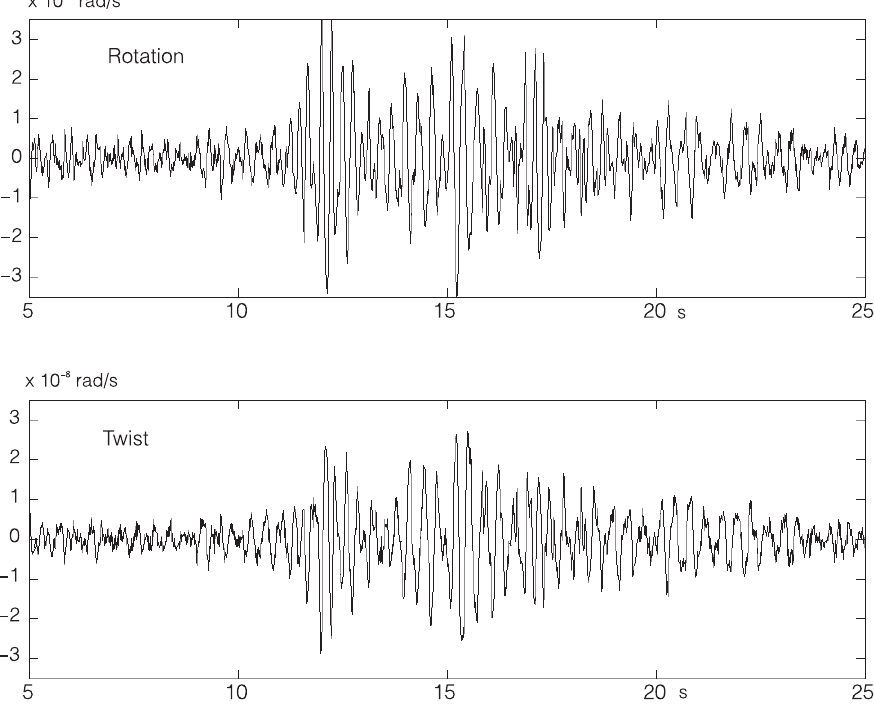
Fig. 9. Records of the rotation and twist velocity components (Ojcow Observatory; as